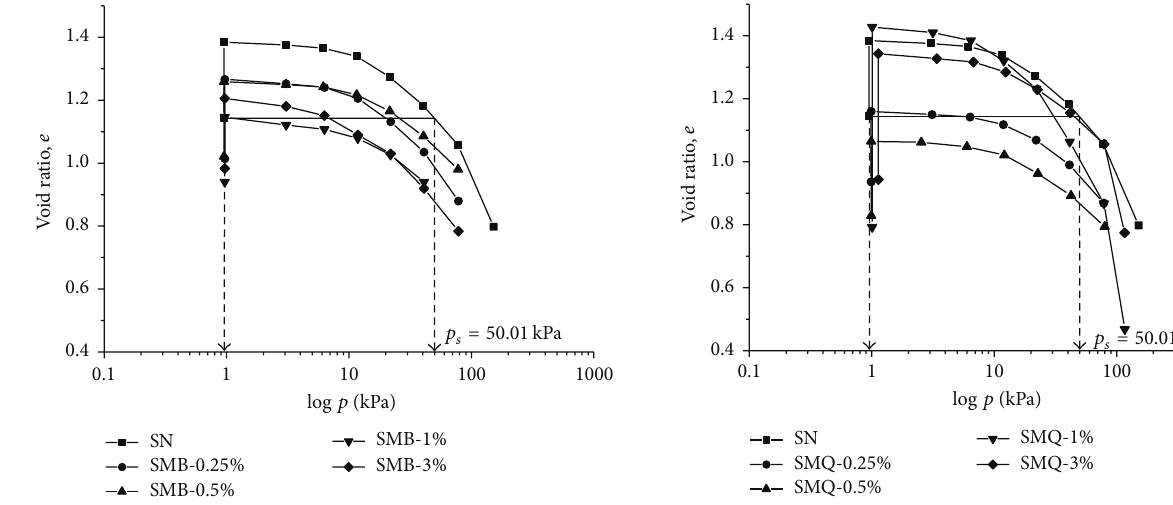
Figure 4: 𝑒 -log 𝑝 curves of soil modified with quill